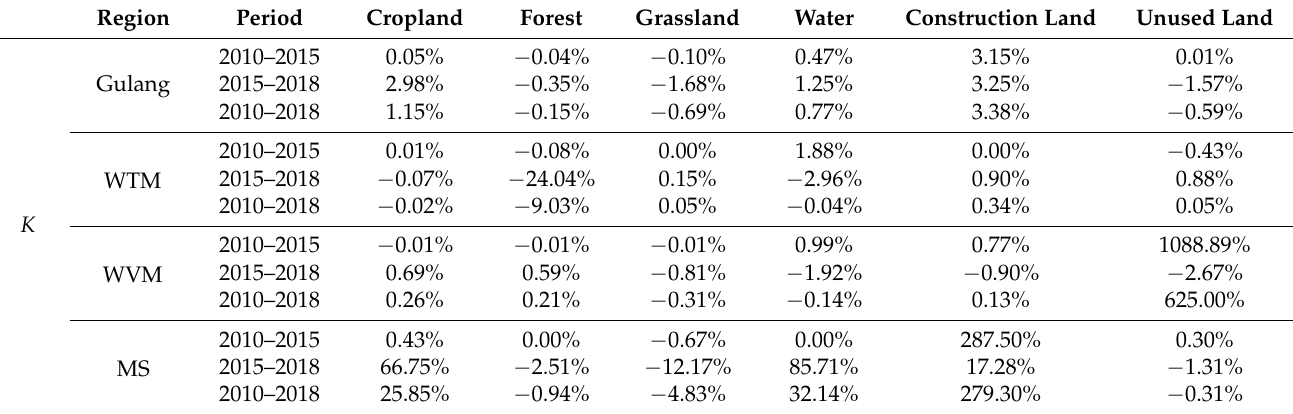
Table 2. Changes in land use dynamic degree, 2010–2018.